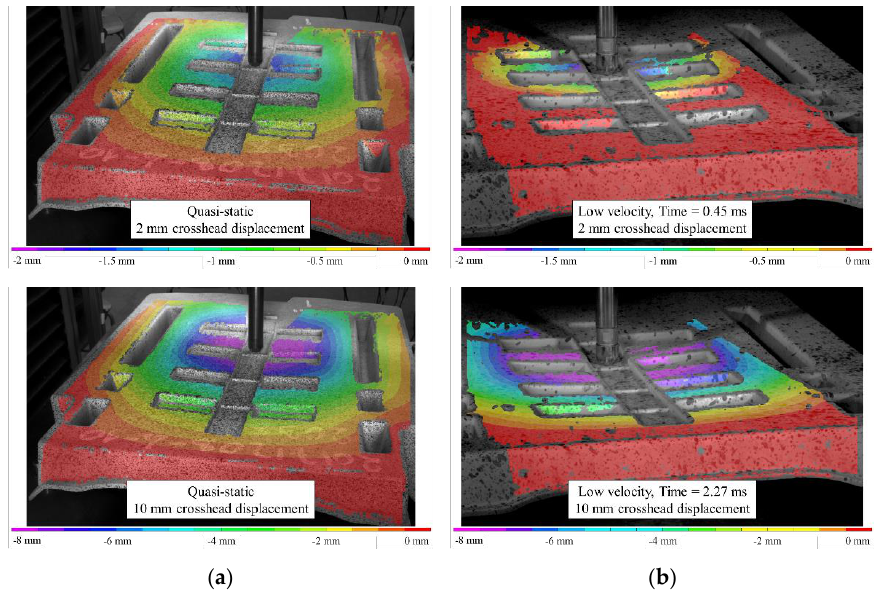
Figure 22. ( a ) Quasi-static and ( b ) low velocity impact loading comparison for longitudinal charge seatbacks: z-deflection contours. seatbacks: z-deflection